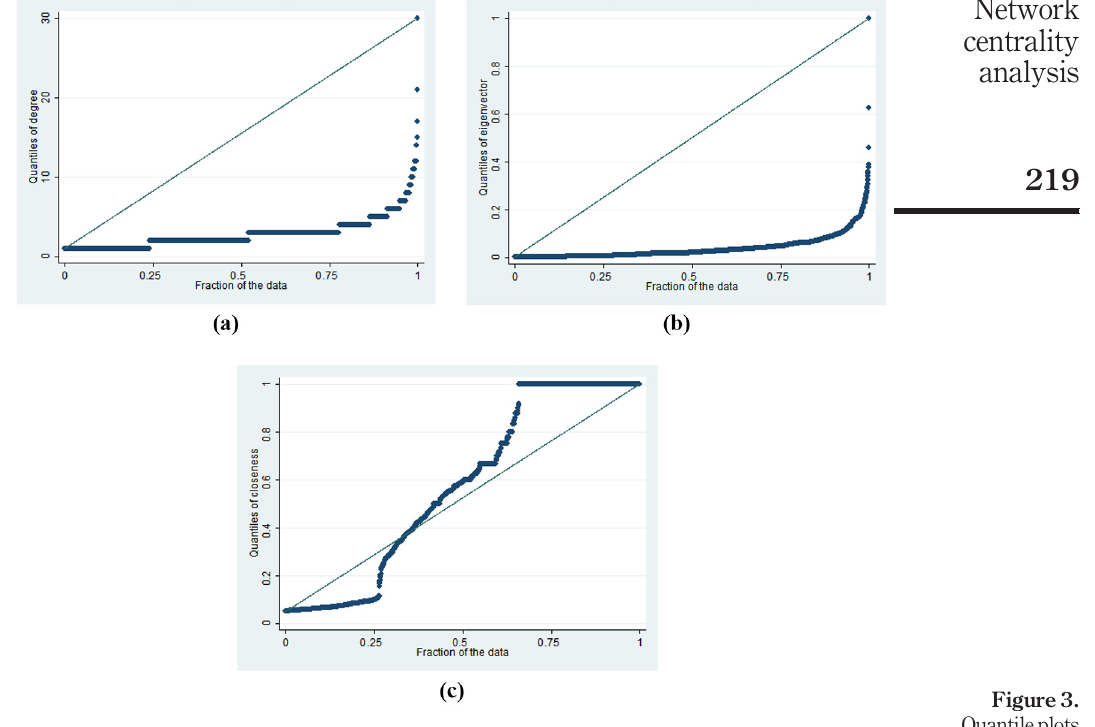
Figure 3. Quantile plots